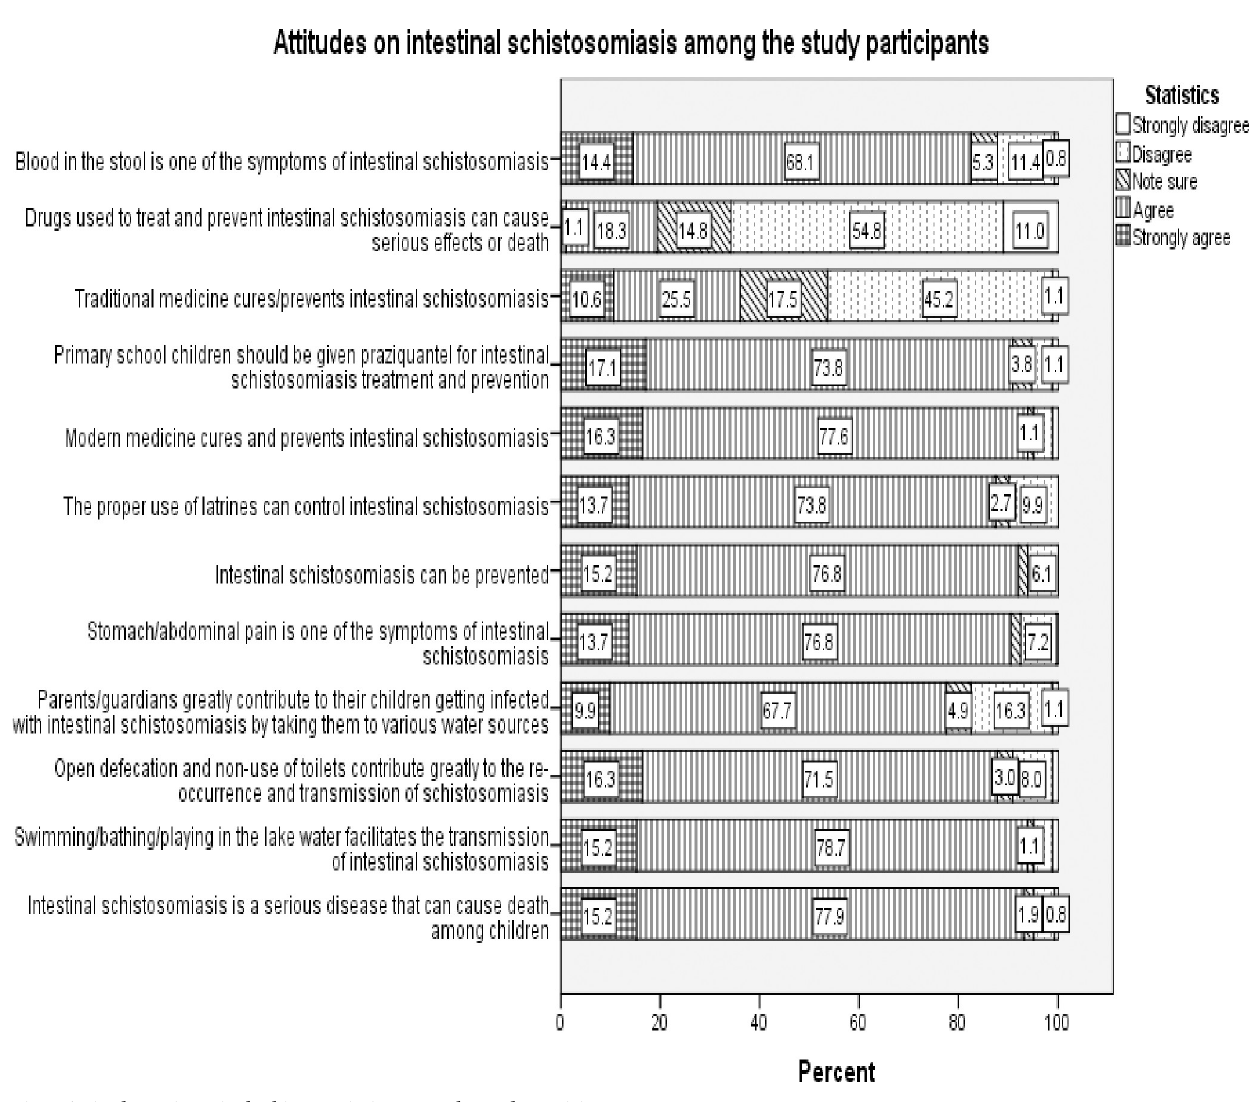
Fig 3. Attitudes on intestinal schistosomiasis among the study